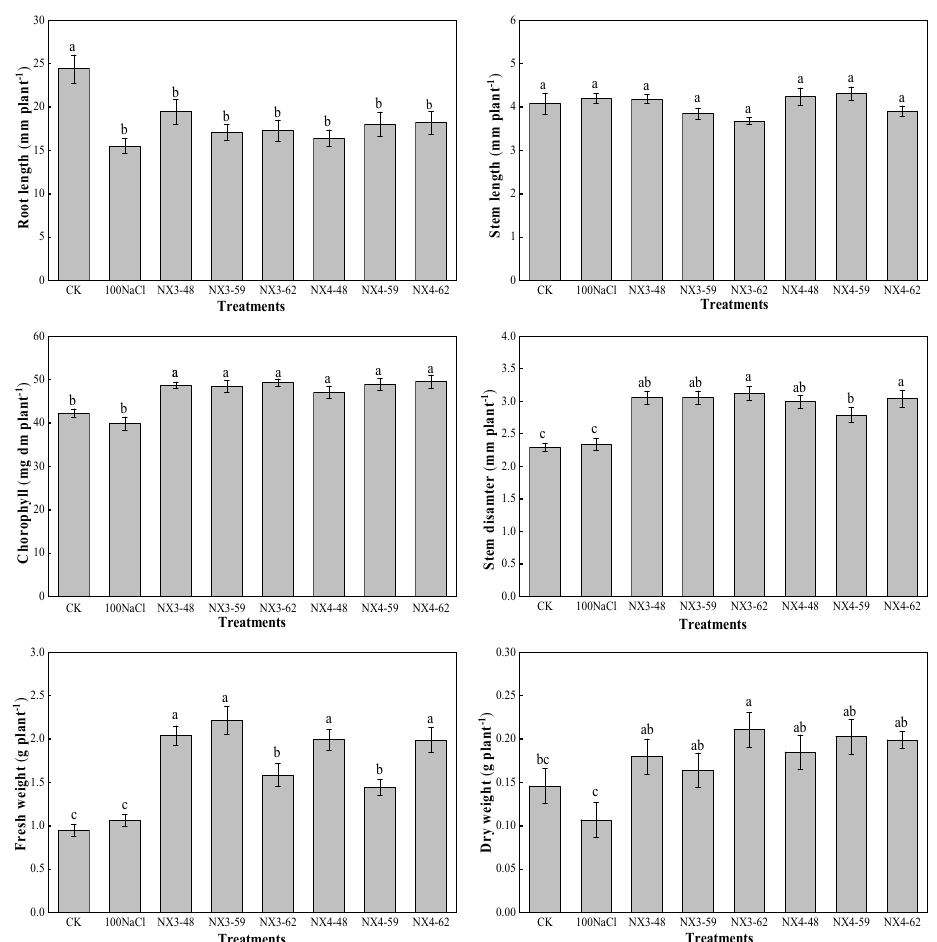
Figure 3. Growth of cucumber seedlings inoculated with a combination of Bacillus licheniformis and Bacillus subtilis under salt stress. Bars represent standard errors. Different letters indicate a significant difference in the same parameter between treatments at p < 0.05.